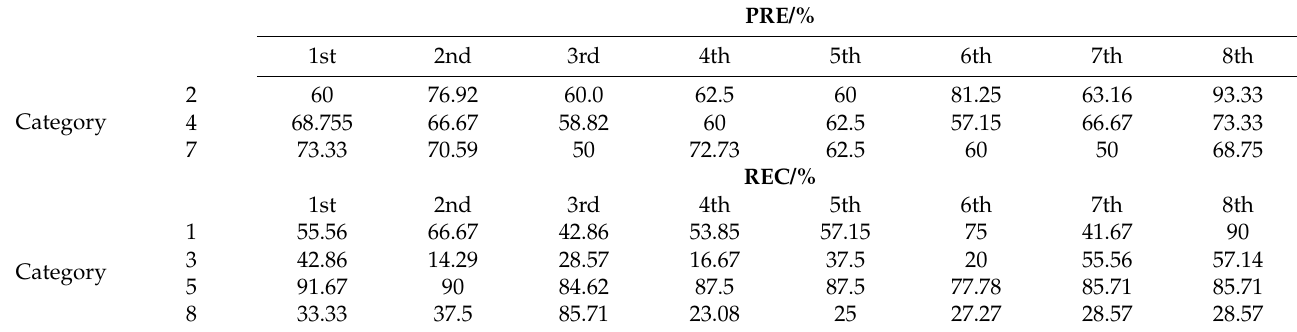
Table 3. Statistics of precision and recall less than 100%.